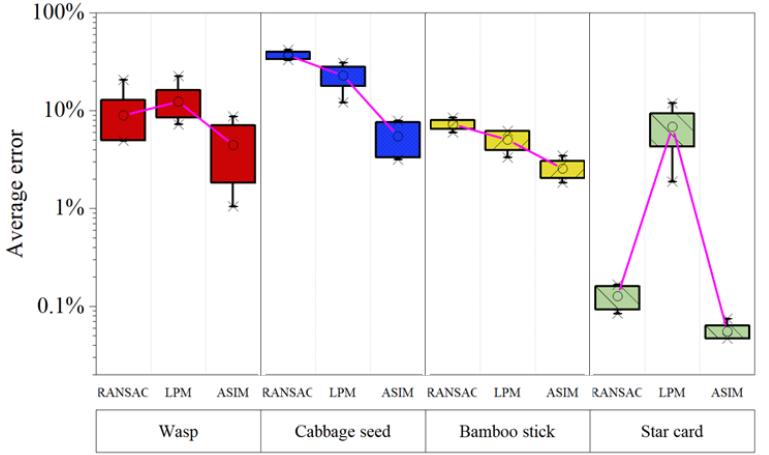
Figure 5. Robustness test of elimination methods. Each column corresponds to a sample listed in Table 3. In each column, the error results for different initial numbers of features are consolidated into a bin. The mean error of the calculated results is represented as ‘ ◦ .’ The maximum and minimum value of data are represented as ‘*.’ The top and bottom borders of the box represent 0.75 and 0.25 points of data, respectively.